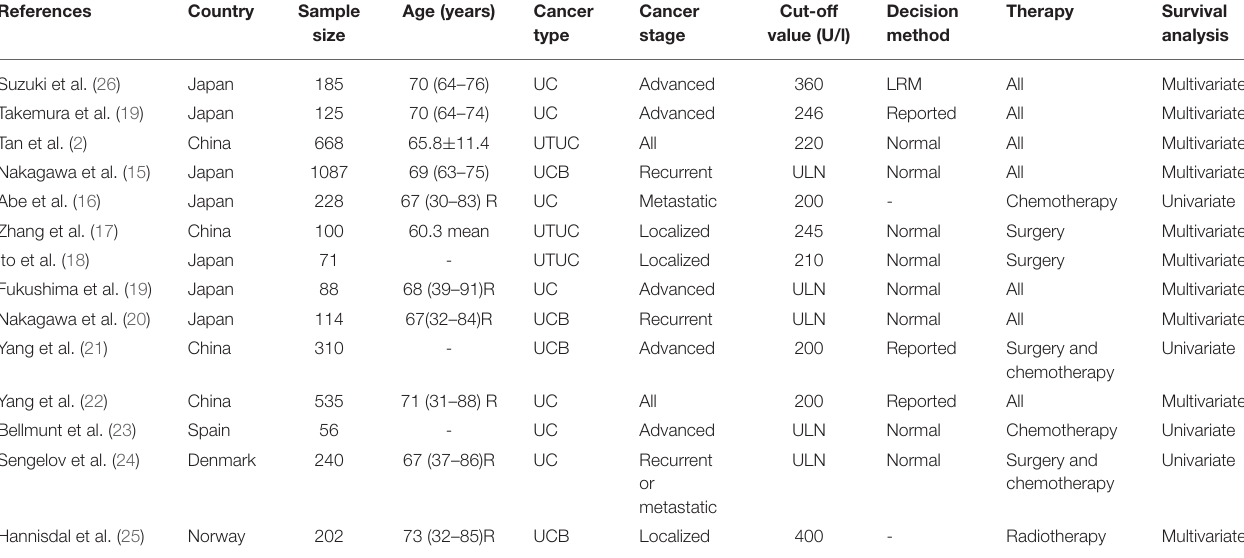
TABLE 1 | Baseline features of included studies.